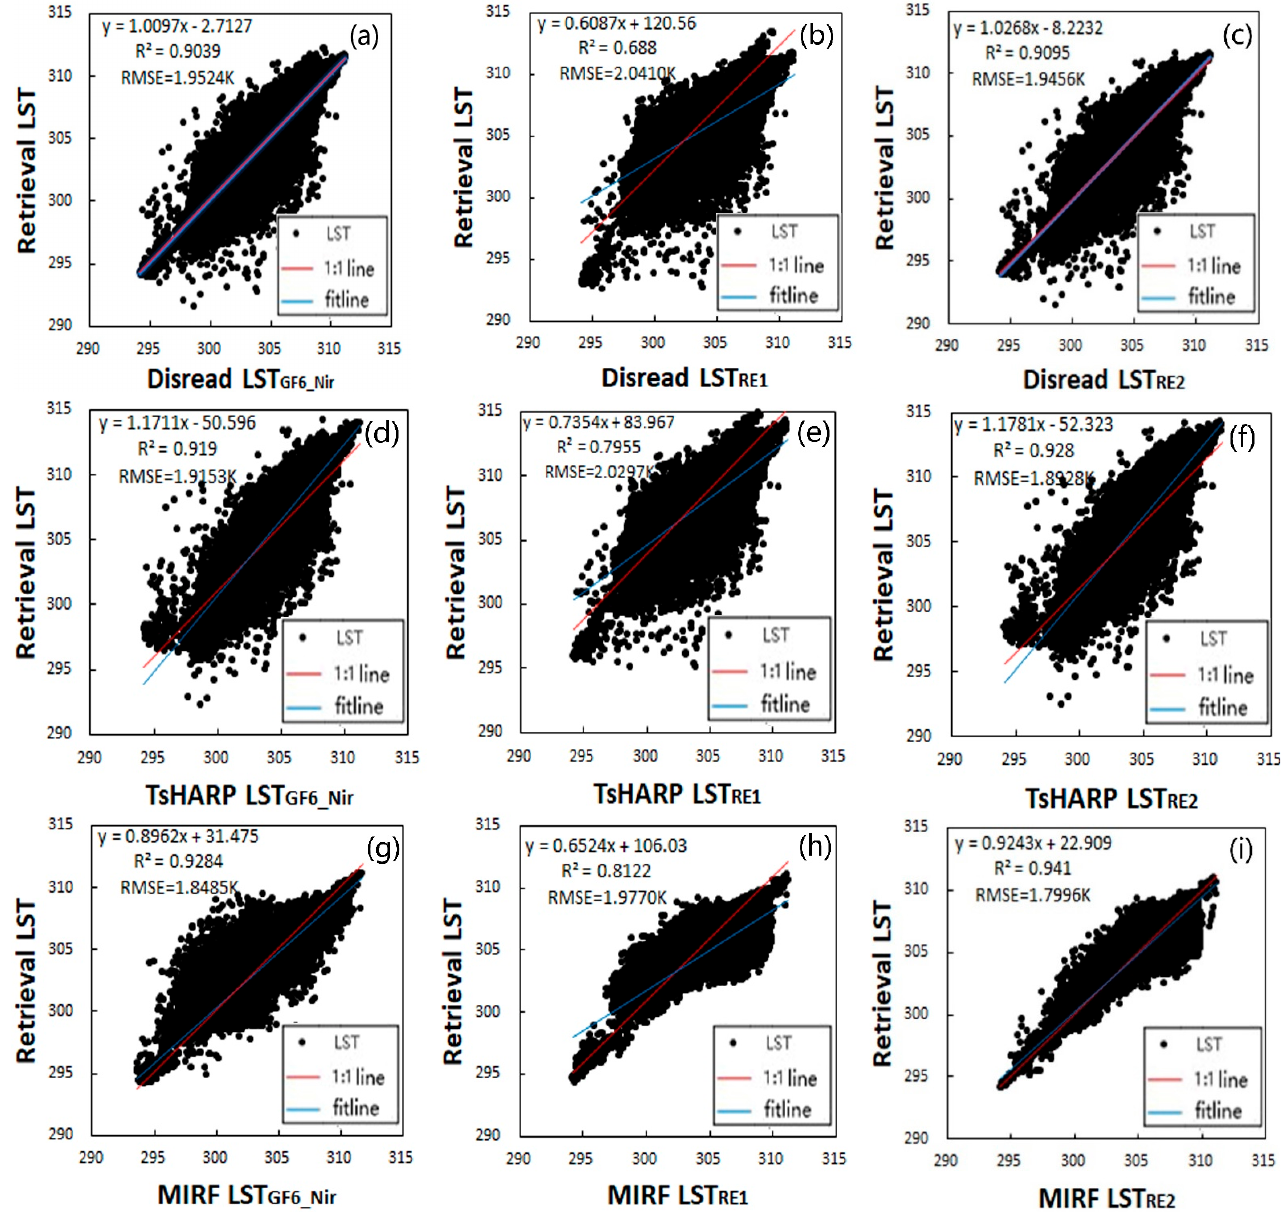
Figure 9. Scatter plot of the Landsat-8- and GF-6-retrieved LST dataset and downscaled results obtained using three different downscaling methods with different GF-6 bands on 26 August 2019 (in units of K). ( a ) DisTrad 𝐿𝑆𝑇 (cid:3008)(cid:3007)(cid:2874)_(cid:3015)(cid:3036)(cid:3045) , ( b ) DisTrad 𝐿𝑆𝑇 (cid:3019)(cid:3006)(cid:2869) , ( c ) DisTrad 𝐿𝑆𝑇 (cid:3019)(cid:3006)(cid:2870) , ( d ) TsHARP 𝐿𝑆𝑇 (cid:3008)(cid:3007)(cid:2874)_(cid:3015)(cid:3036)(cid:3045) , ( e ) TsHARP 𝐿𝑆𝑇 (cid:3019)(cid:3006)(cid:2869) , ( f ) TsHARP 𝐿𝑆𝑇 (cid:3019)(cid:3006)(cid:2870) , ( g ) MIRF 𝐿𝑆𝑇 (cid:3008)(cid:3007)(cid:2874)_(cid:3015)(cid:3036)(cid:3045) , ( h ) MIRF 𝐿𝑆𝑇 (cid:3019)(cid:3006)(cid:2869) , ( i ) MIRF 𝐿𝑆𝑇 (cid:3019)(cid:3006)(cid:2870) .